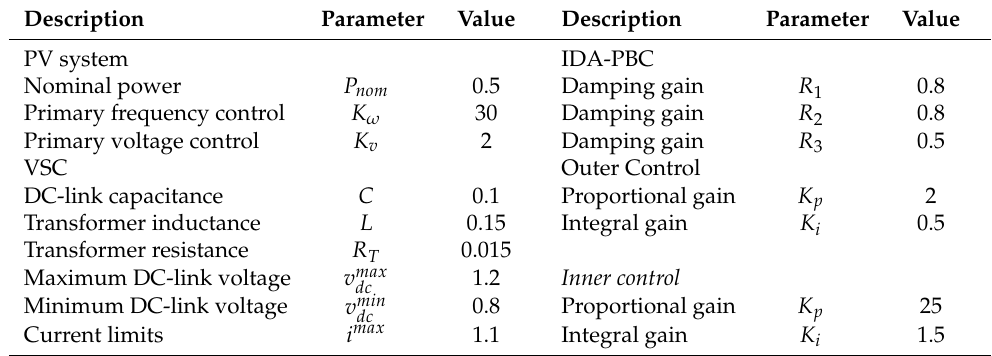
Table 1. Data and parameter